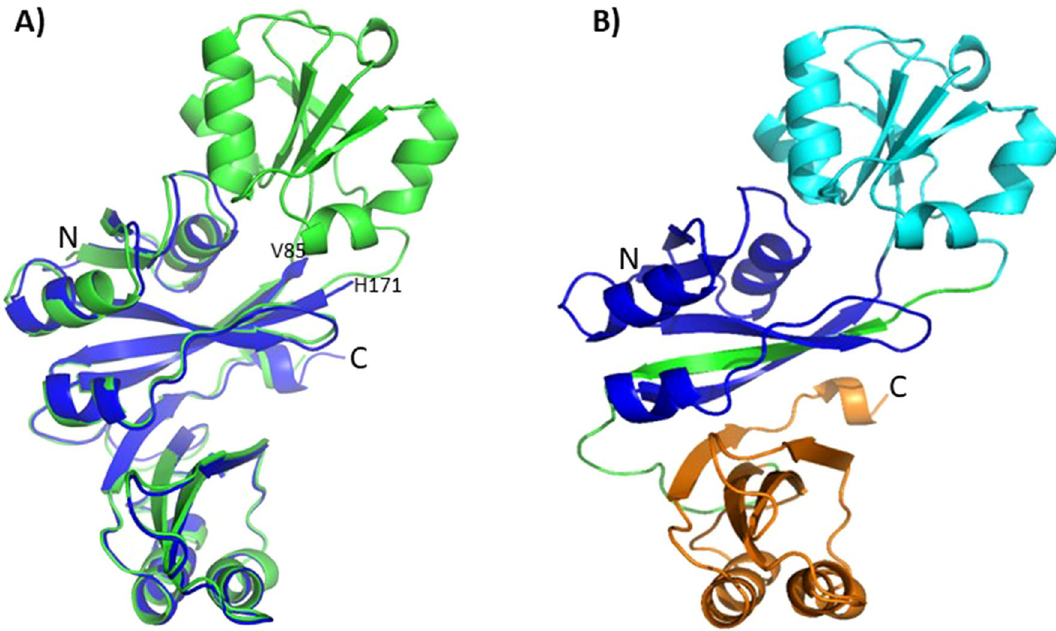
Figure 5. Structural analysis of GqqA and SeGqqA. ( A ) superposition of GqqA (green) and SeGqqA (blue) highlights that one protein domain is missing in SeGqqA. The artificial termini after truncation are labelled (V85, His171). ( B ) The N-terminal (blue) and C-terminal (orange) domains are stabilized through a linker (green), which connects the middle domain to the C-terminal ACT domain. This linker is integrated in the N-terminal